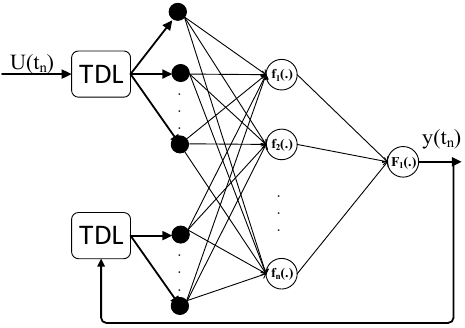
Figure 2. Architecture of the NARX network configured with tapped delay lines (TDLs).